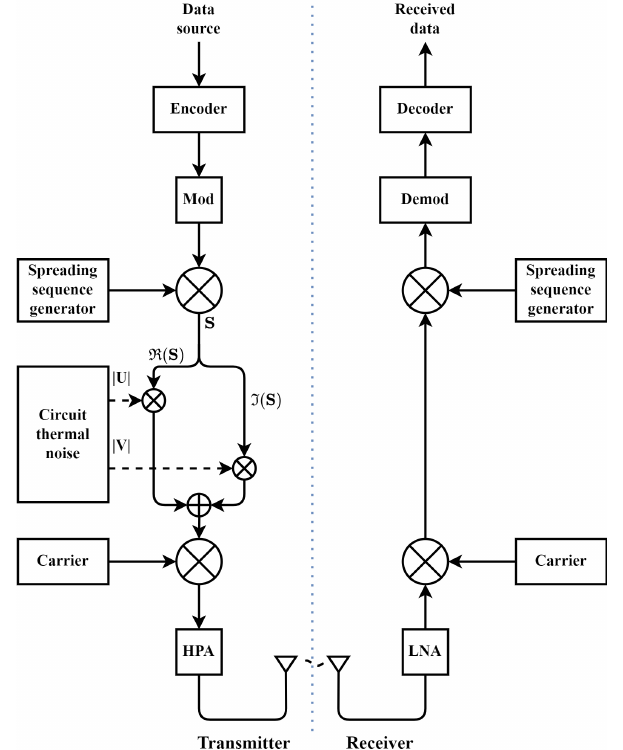
Figure 4. Proposed GDSS